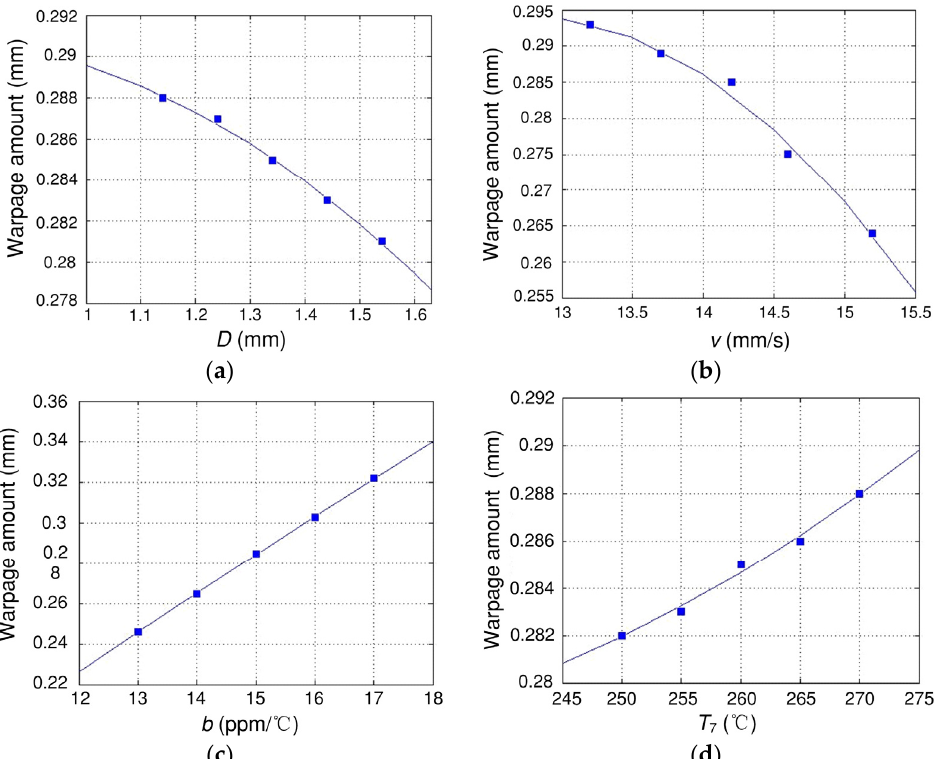
Figure 7. Analysis of the factors that influence warpage. ( a ) PCB thickness. ( b ) Conveyor belt speed. ( c ) CTE of PCB. ( d ) Temperature in the 7th oven zone.